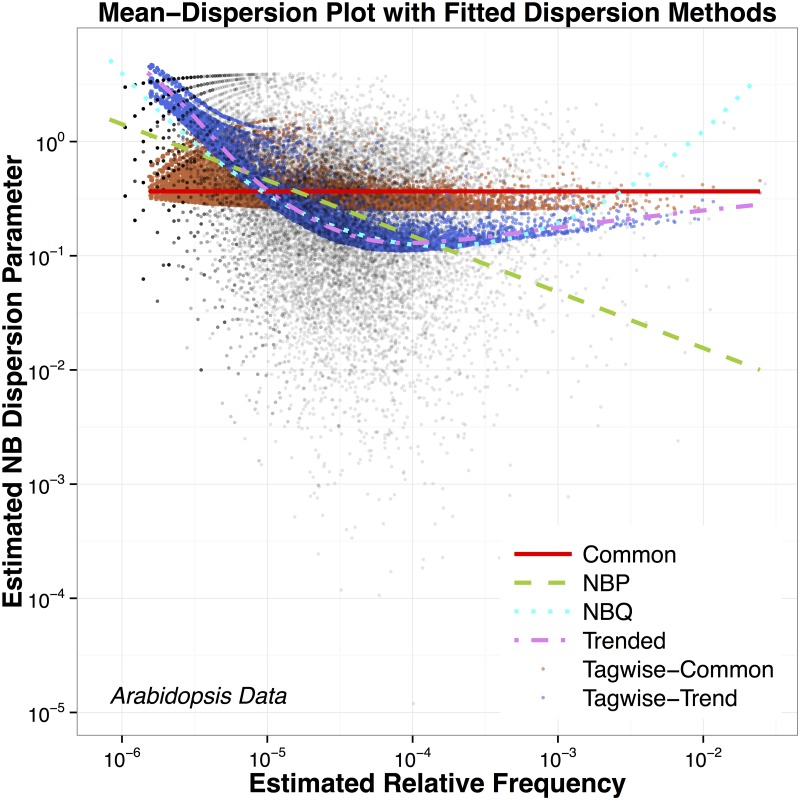
Mean-Dispersion Plot with Fitted Dispersion Models.The mean-dispersion plot with six fitted dispersion models (common, NBP, NBQ, trended, tagwise-common and tagwise-trend) for the Arabidopsis RNA-Seq dataset (19,623 genes from three biological samples in the mock treatment group). For better visualization, we use dots instead of curves for the tagwise procedures to indicate the variability of individual NB2 dispersion parameters about the trend.